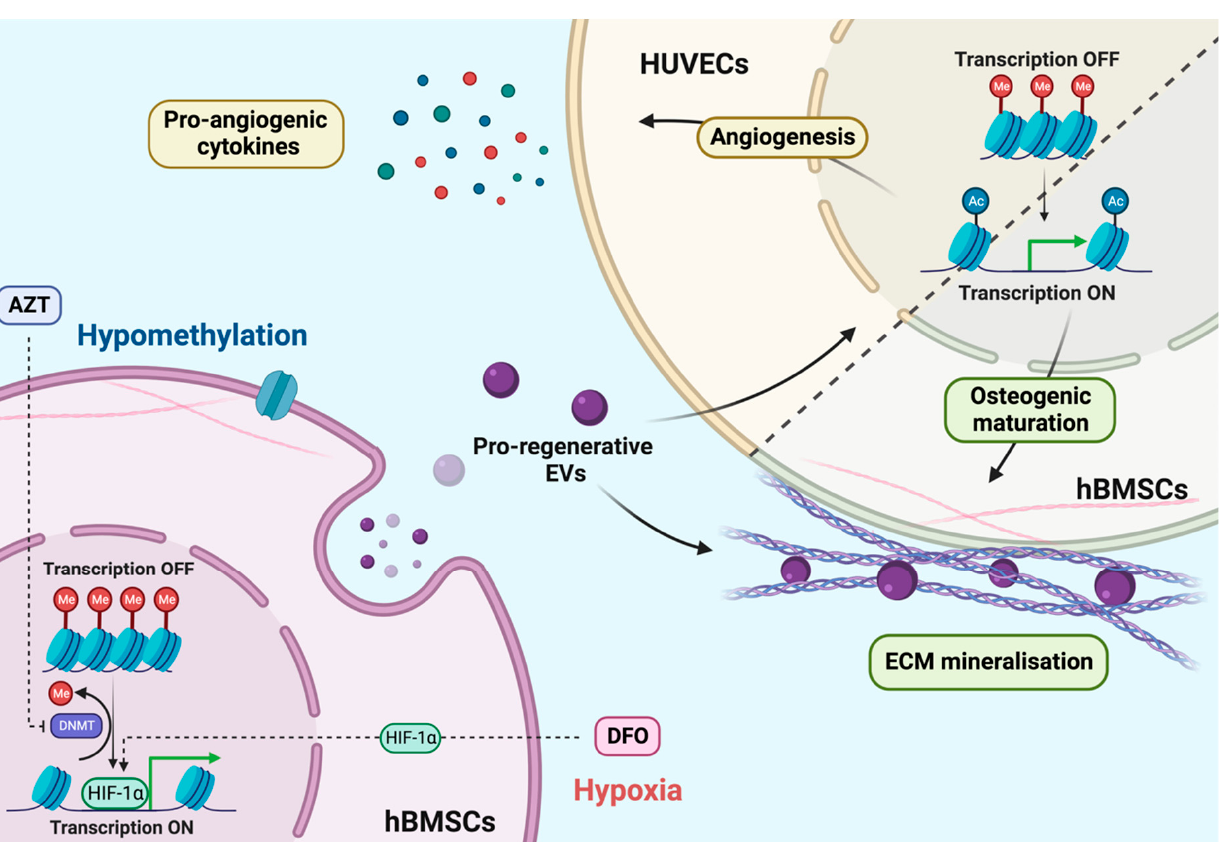
effects without the side effects on viability [4,28]. To define the optimum treatment